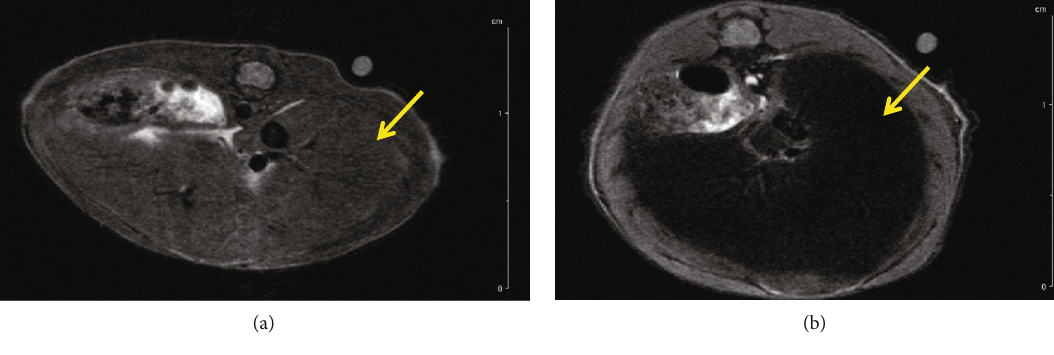
Figure 5: RARE-liver prescan (a); RARE-liver 60min p.i. (b).